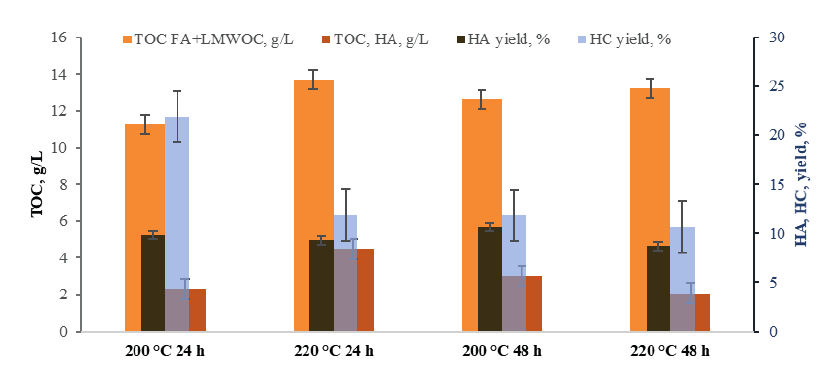
Fig. 2. Effect of temperature and time on the yield of humic and fulvic acids and hydrochar as a result of hydrothermal carbonation of WS biomass. Temperature has a significant effect on the yield of HC, and the results show that as the temperature increases, the yield of HC decreases, most likely due to the hydrolysis and decomposition of cellulose, hemicellulose and lignin. The highest yield of hydrochar was obtained by hydrothermal carbonization of wheat straw for 24 h at 200 ºC. To assess